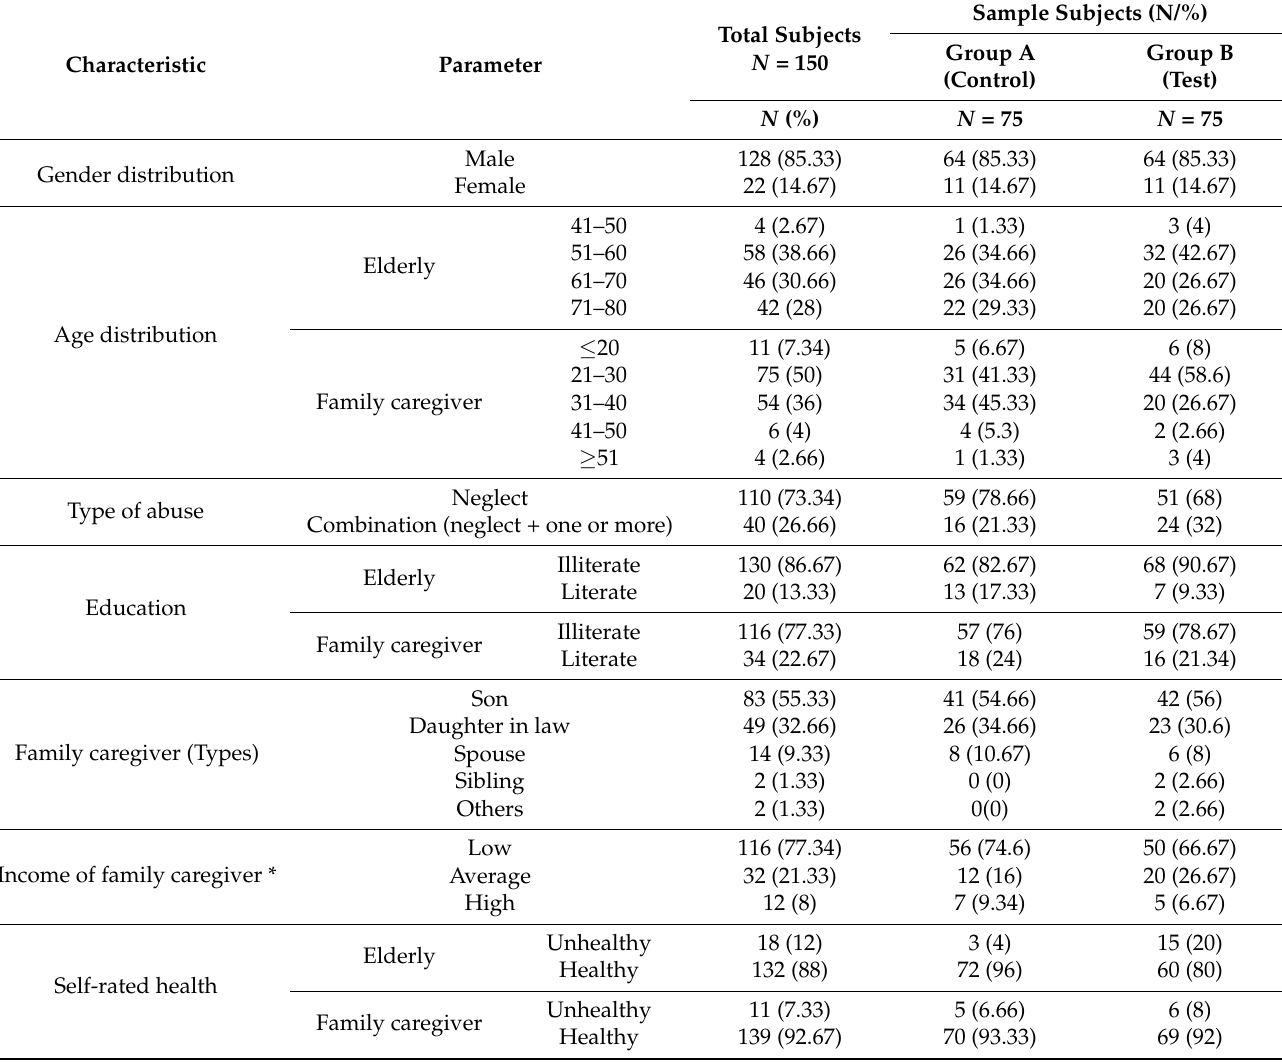
Table 1. Group comparison of sociodemographic characteristic distribution in the studied